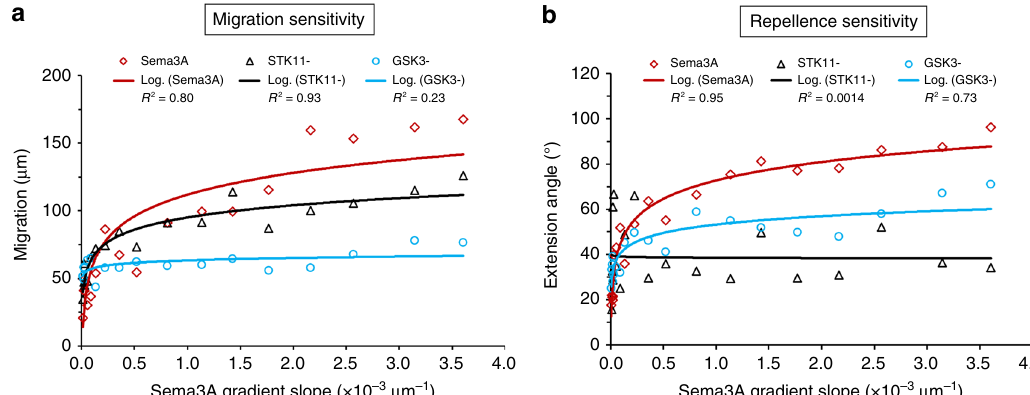
Fig. 7 Summary of neuronal sensitivity to the steepness of Sema3A gradient. a Cell migration and b neurite repellence under different conditions, including Sema3A only (red, square), Sema3A plus STK11 knockdown (STK − , black, triangle), or Sema3A plus GSK3 inhibition (GSK3 − , blue, circle). The solid lines indicate the logarithmic fi tting of the data point. Data were quanti fi ed from at least three biological replicates. The association of neuronal growth (neurite guidance or soma migration) with the steepness of chemotactic gradient was examined using a linear fi t for the neuronal growth parameters and gradient steepness variation. A p -value was calculated for the regression coef fi cient (gradient steepness), which, in a linear regression model, is based on a t -test with a null hypothesis that the coef fi cient is zero, and p < 1 × 10 − 2 indicates a signi fi cant association. The summary of p -values is included in